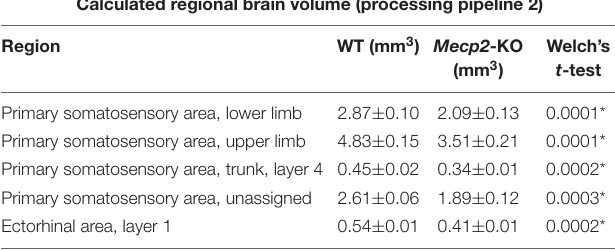
TABLE 4 | List of significantly altered each regional brain volume in Welch’s t -test (Processing pipeline 2). Calculated regional brain volume (processing pipeline 2)